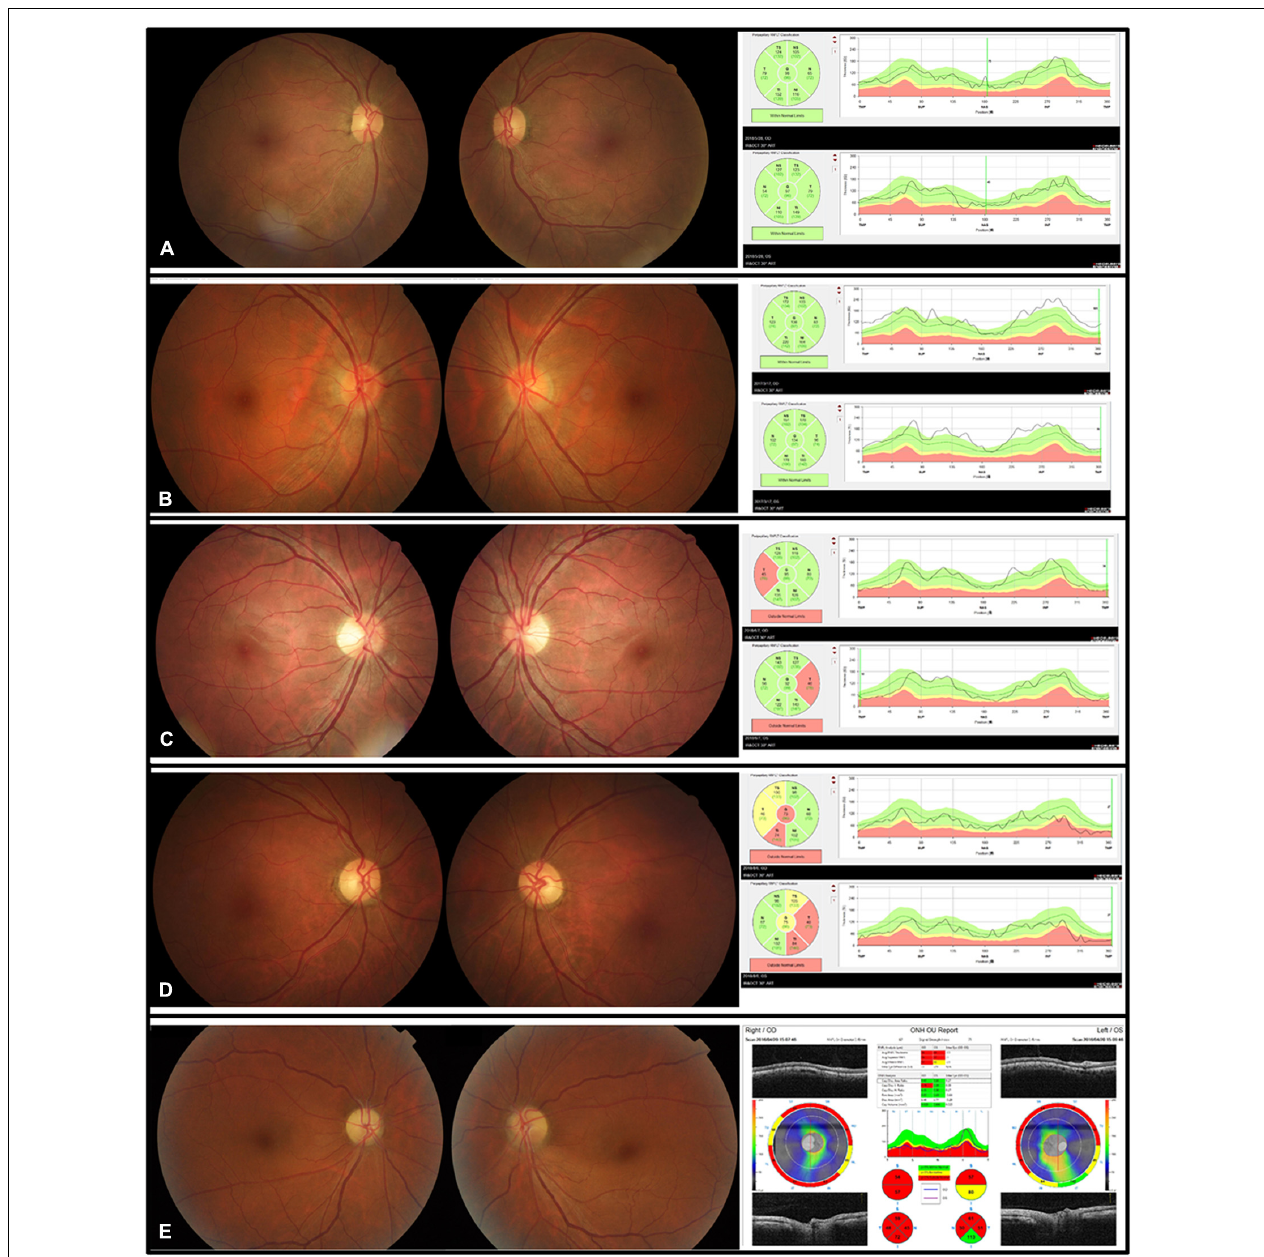
FIGURE 1 | Five kinds of disc appearances and OCT images in five patients with EON. (A) The disc appearance and the RNFL thickness were normal. (B) The optic discs were hyperemic. The superior, temporal, and inferior RNFL was thickened. (C) The border of the nasal discs was blurred and the temporal discs were pale. The temporal RNFL thickness was thinner than normal. (D) The temporal discs were pale and the temporal RNFL became thin. (E) The optic discs were pale, with the inferior border of the disc blurred in the left eye.